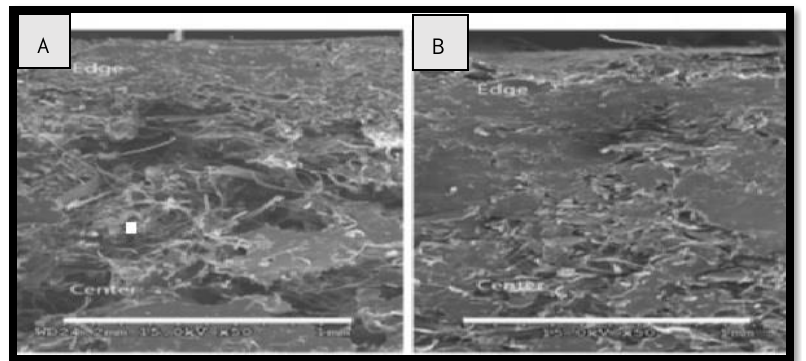
Figure 1. SEM images of the cross-sections of ground quill–PP composites at a temperature of 195 ◦ C with a ground quill concentration of ( A ) 20% and ( B ) 35%. Reprinted/adapted with permission from Ref. [48].